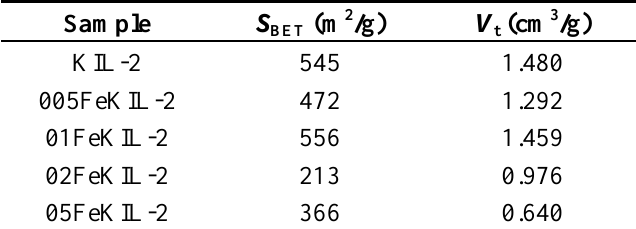
Table 1. BET surface areas ( S adsorption isotherms at 0.98 relative pressure